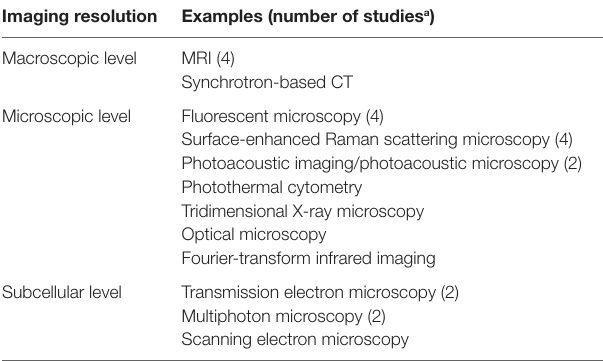
taBLe 2 | Experimental models used in the included studies. experimental model